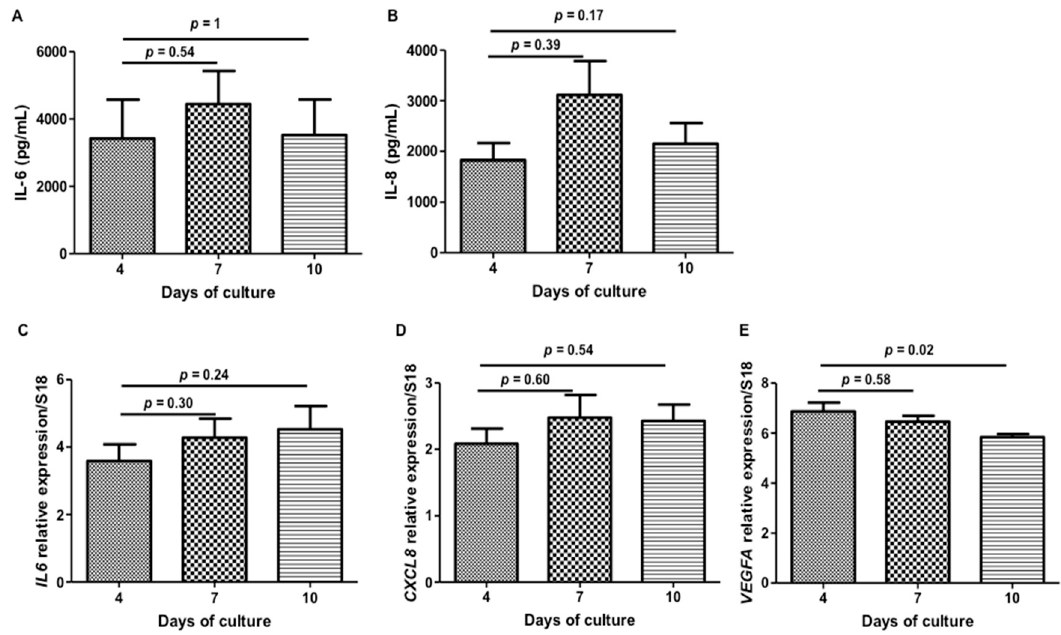
Figure 7. Cell paracrine activity over the time of the study. ( A , B ) Histograms of IL-6 and IL-8 ELISA quantification, respectively, showing non-significant production of related proteins; ( C – E ) Histograms of IL6 , CXCL8 , and VEGFA qRT-PCR analysis, showing non-significant regulation of IL6 and CXCL8 , and significant VEGFA down-regulation ( n = 6, Mann and Whitney statistical test, p < 0.05 for four versus 10 days of culture).